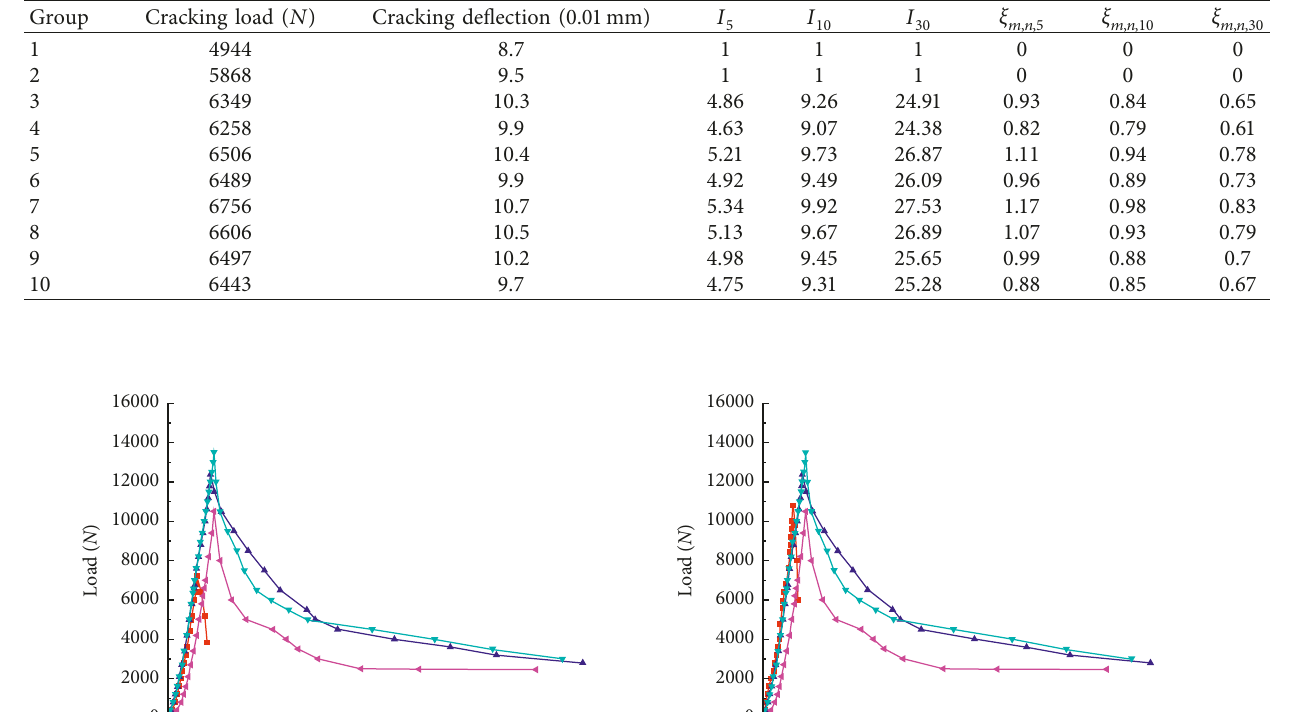
Table 5: Test results of bending toughness.